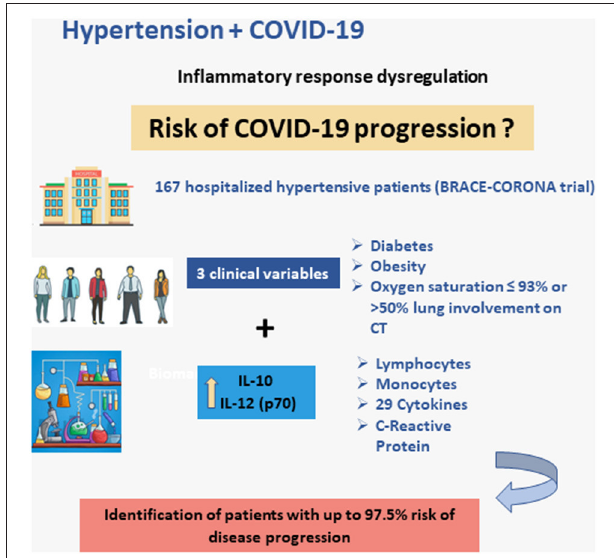
FIGURE 2 | Schematic illustration of the main findings: model for the prediction of the risk of progression of COVID-19 including three clinical variables and two biomarkers: IL-10 and IL-12 (p70).